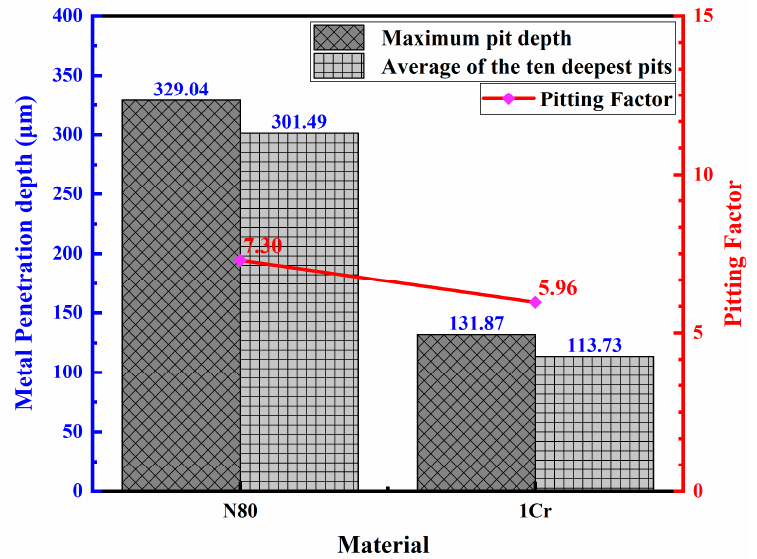
Figure 10. Pi tt ing Penetration Depth and Pi tt ing Factors of N80 and 1Cr at 50 °C-CO 2 : 0.30 MPa.